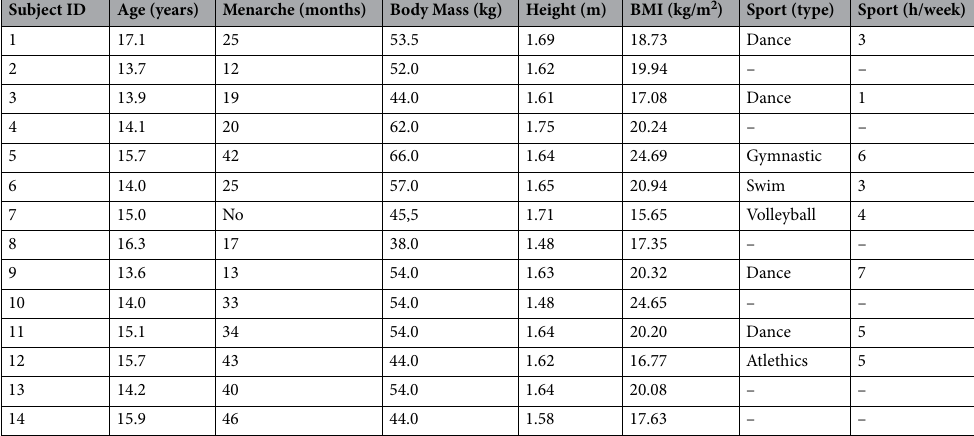
Table 1. Adolescents with AIS’ descriptive characteristics.